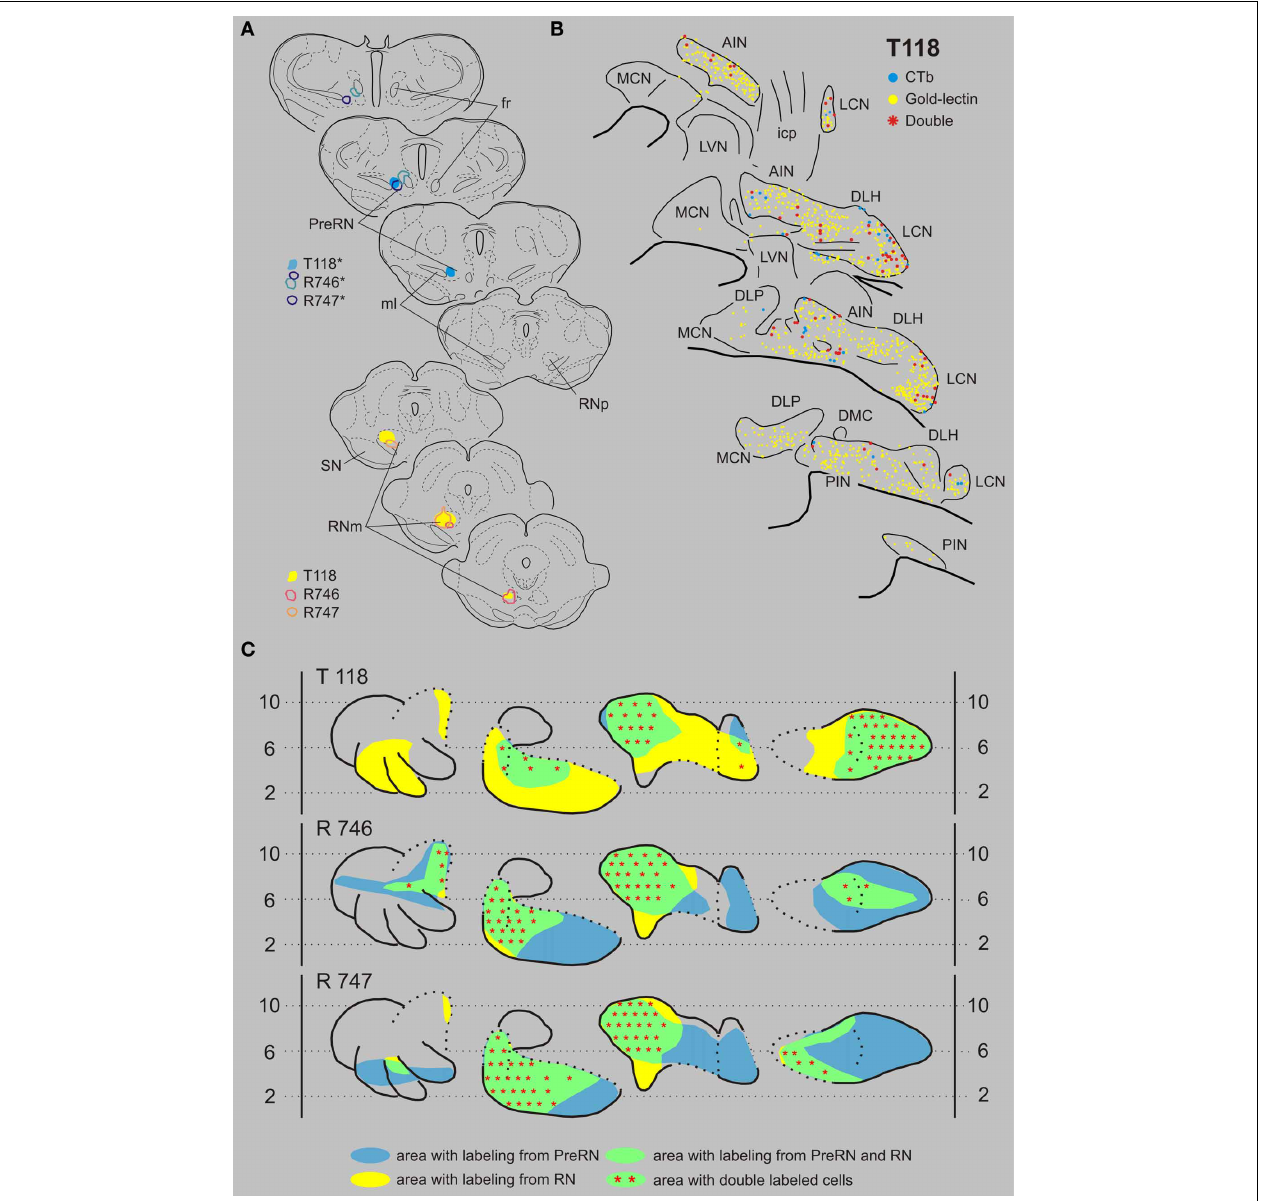
case T118. (C) Overview of the distribution of retrogradely labeled neurons of case T118 and of the two additional cases (R746 and R747) in standardized diagrams of the CN. Areas containing labeled neurons from the RN and PreRN are indicated in blue and yellow, respectively. Note that all overlapping areas (green) contain double labeled neurons (red symbols). Conventions and abbreviations as in Figures 3 – 5